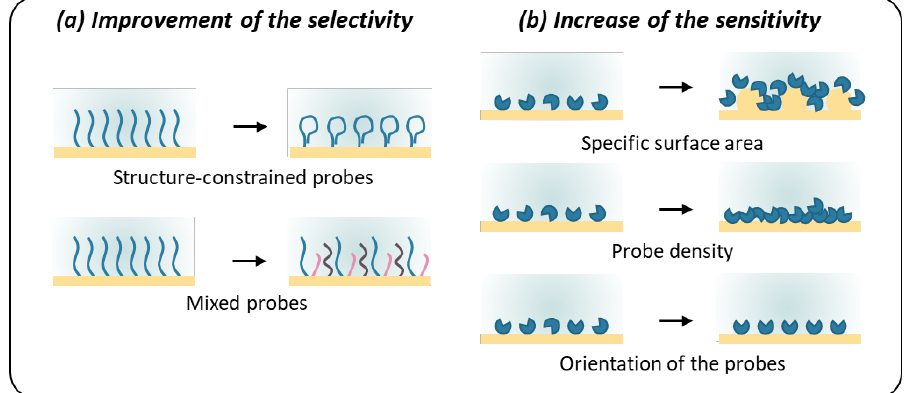
Figure 5. The immobilization of the sensing material on the surface of the sensor is key to make full use of its sensing potential and to ensure the highest sensitivity and selectivity.